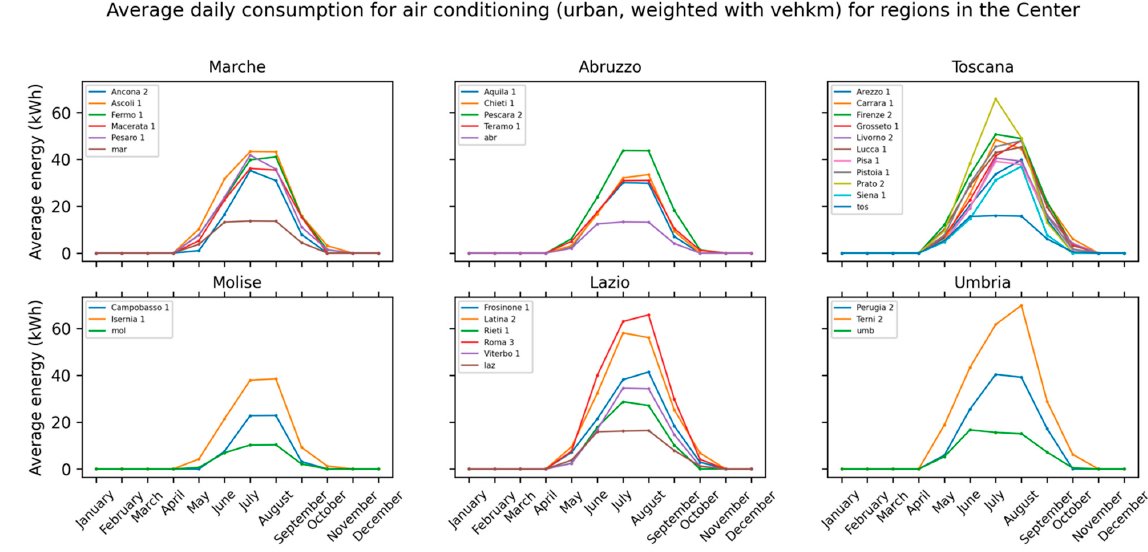
Figure 8. As Figure 7 for Central Italian Regions.